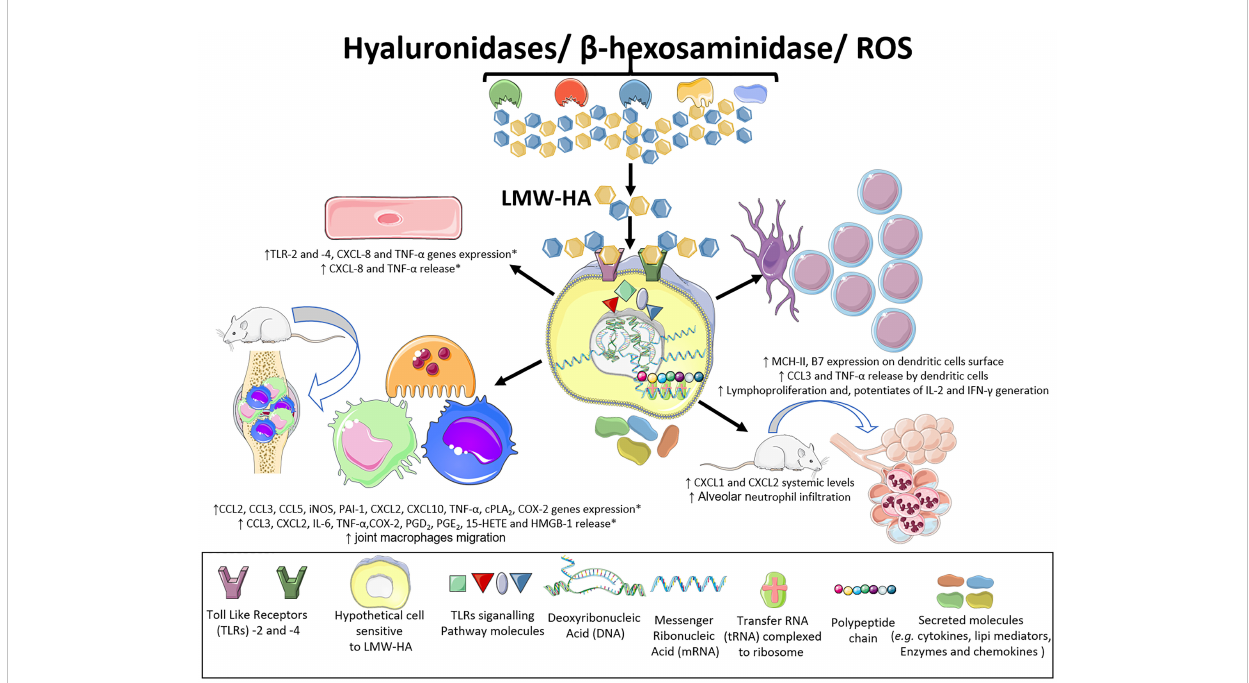
FIGURE 4 In fl ammatory effects of LMW-HA fragments. LMW-HA can be sensed by different cell types. By performing in vivo, in vitro and ex-vivo experiments, using diverse pharmacological strategies, genetic interference and knock out mice, various studies have shown that LMW-HA fragments, in their DAMP form, are sensed by TLR-2 and -4, on endothelial cells, macrophages and dendritic cells. This event leads to cell activation, with expression of in fl ammatory genes, production of chemokines, interleukins and lipid mediators, modulation of the expression of cell surface molecules and lymphoproliferation. Besides, it can promote in fi ltration of macrophages and neutrophils into the synovial and pulmonary tissues causing joint and alveoli destruction, respectively. (*) effects characterized both in mice and human samples. This Figure was partly generated using Servier Medical Art, provided by Servier, licensed under a Creative Commons Attribution 3.0 unported license. Of note, some icons in this fi gure were adapted for our